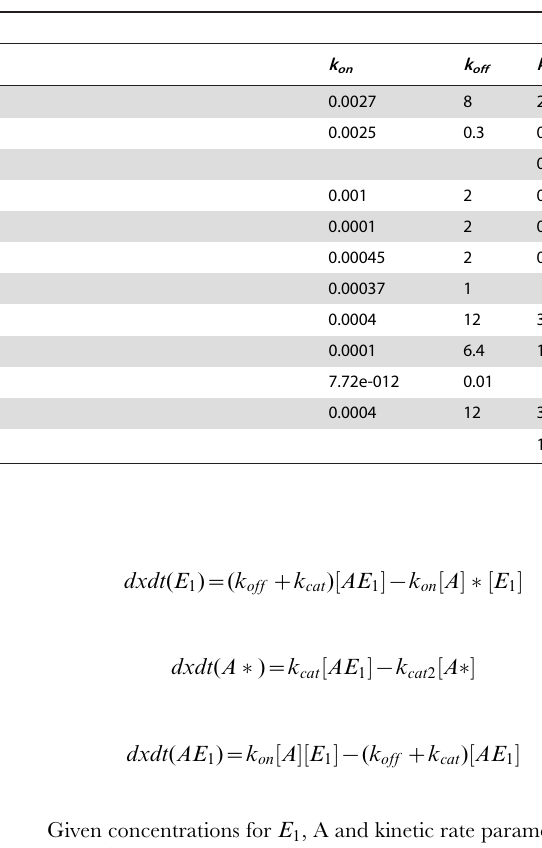
Table 3. DARPP-32 reactions.